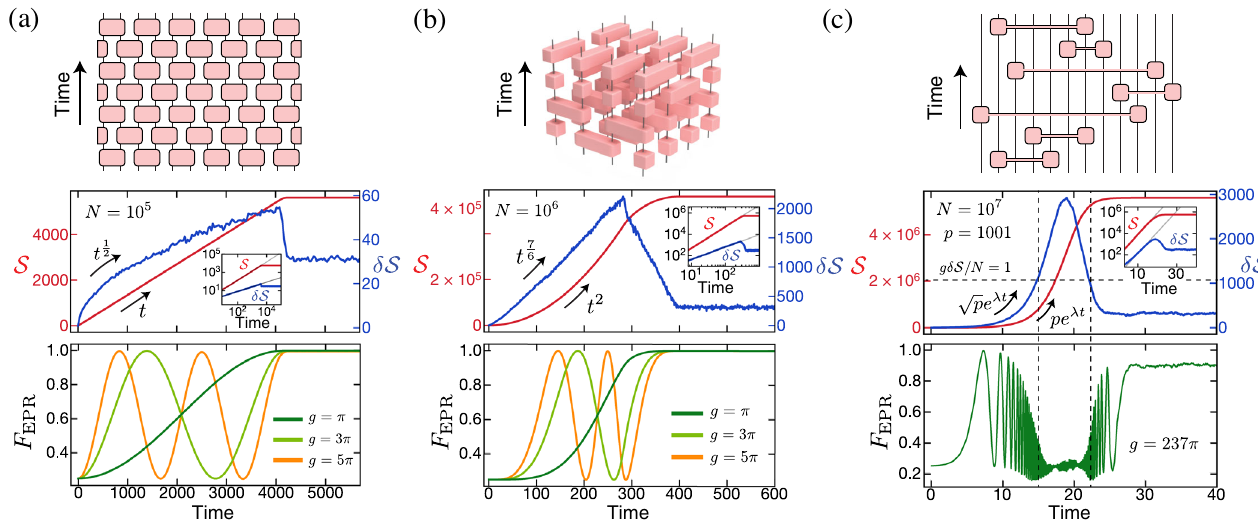
FIG. 2. Numerical results for averaged operator size and teleportation fidelity of 1D, 2D, and 0D RUCs. (a),(b) In 1D and 2D, sizes grow ballistically in time, while the size width grows with a slower power of t and matches predictions from the KPZ universality class (Sec. VIII B). Because of the separation between the size and size width, the teleportation fidelity for a single qubit exhibits an oscillatory behavior at intermediate times, with nearly perfect maximum fidelity. At late times, the teleportation fidelity saturates close to 1 for odd values of g= π , as expected for any scrambling system (Sec. VII). (c) In 0D all-to-all coupled RUCs, both the size and size width grow exponentially in time, and obtaining a large separation between them requires encoding the initial state into p -body operators. With this encoding, the teleportation fidelity displays a distinct three-regime profile for g ≫ 1 . In particular, as in 1D and 2D, peaked-size teleportation succeeds (i) at early times, with an oscillating fidelity, and (ii) at late times, where the fidelity saturates close to 1 (for odd g= π ). Between these regimes, no teleportation occurs, because the size width grows too large: g δ S =N ≳ 1